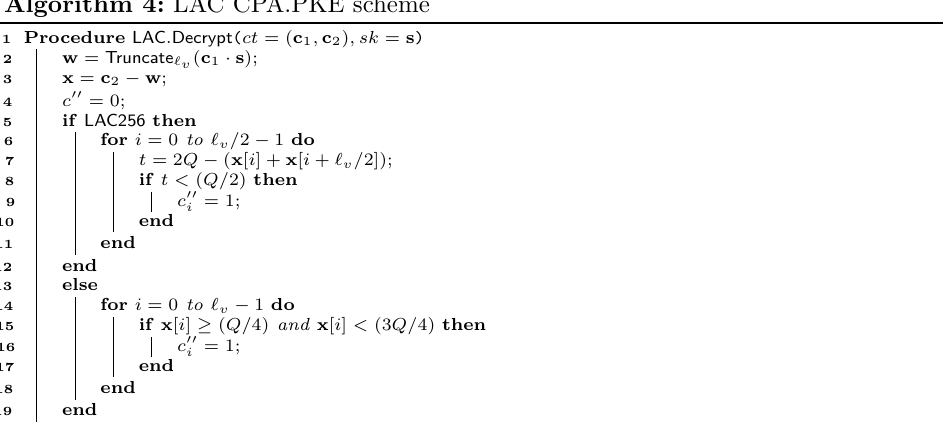
Algorithm 4: LAC CPA.PKE